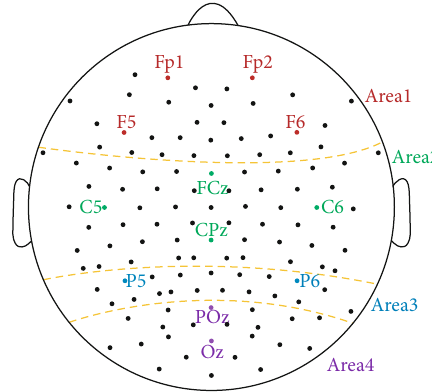
Figure 1: The electrode distribution of the mental fatigue